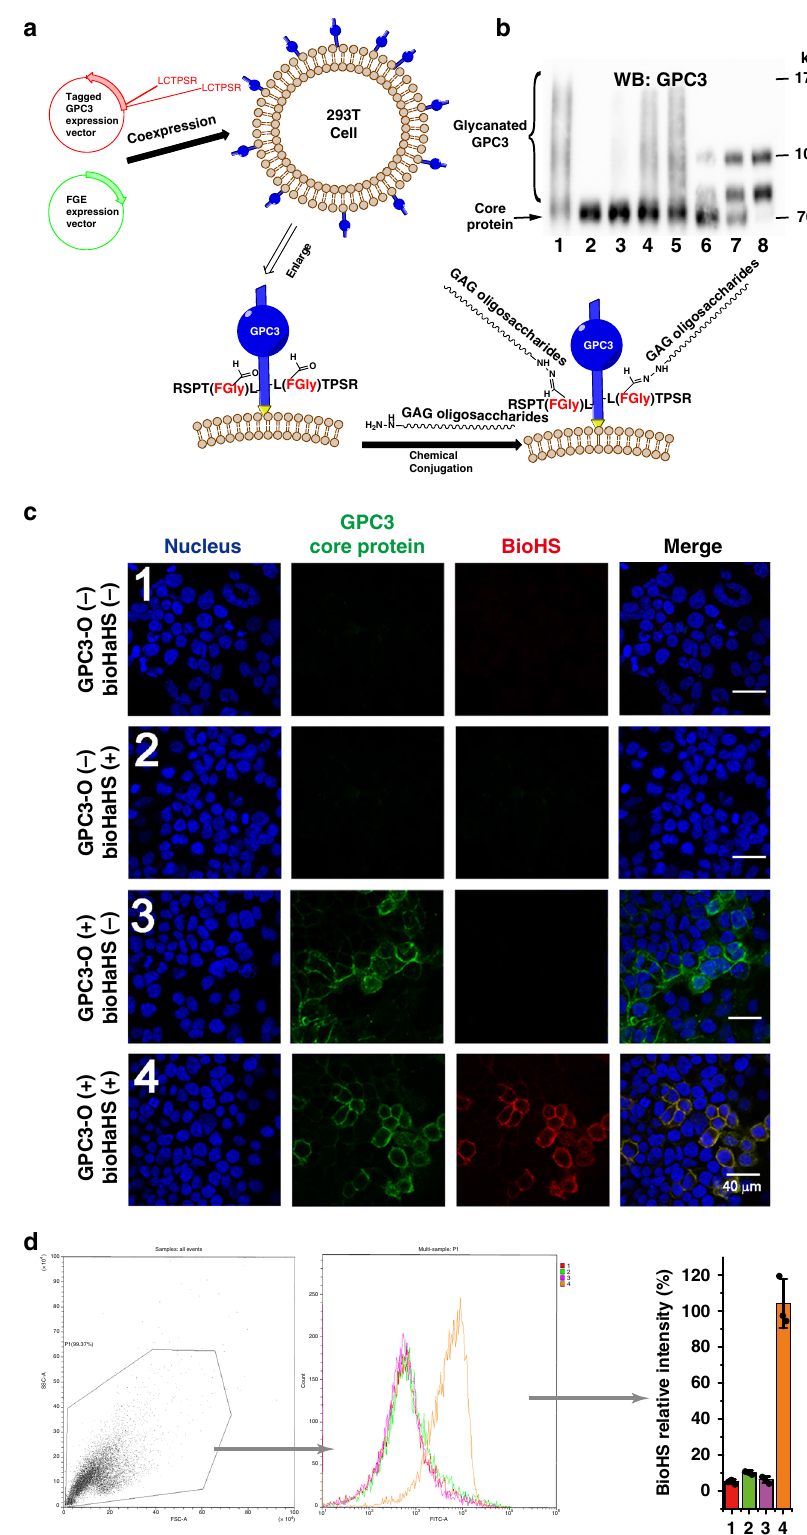
Functional analysis of GPC3 attached to speci fi c GAG chains . It is well established that the function of PGs is highly dependent on the type of GAG chains attached to the core proteins. In the Wnt signaling 24 , and in the inhibition of Hh signaling 25 . We